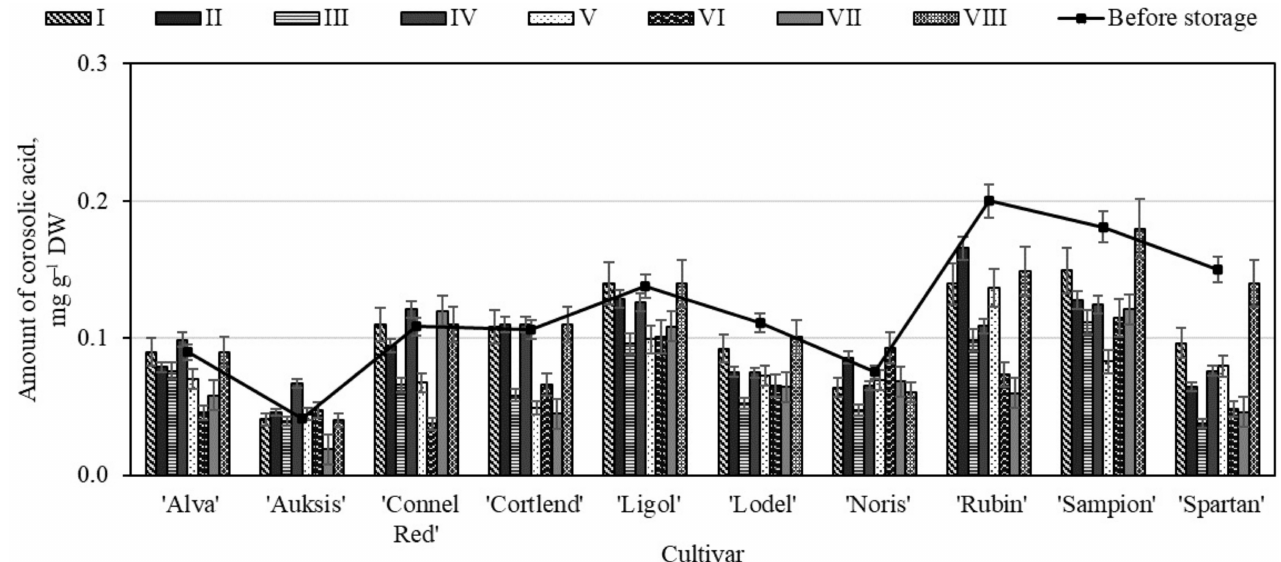
Figure 5. Changes in the amount of corosolic acid in the whole apple samples before and after storage in